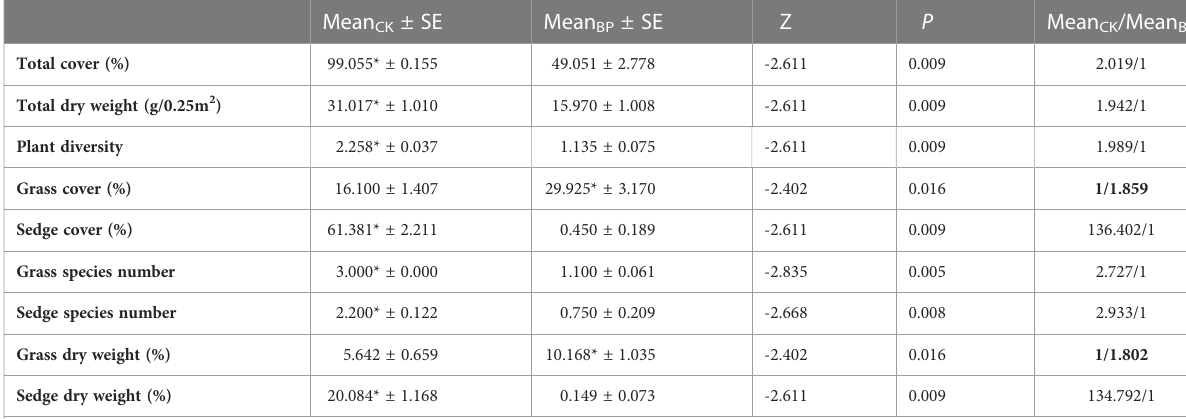
TABLE 1 Mean value of plant indices across the fi ve